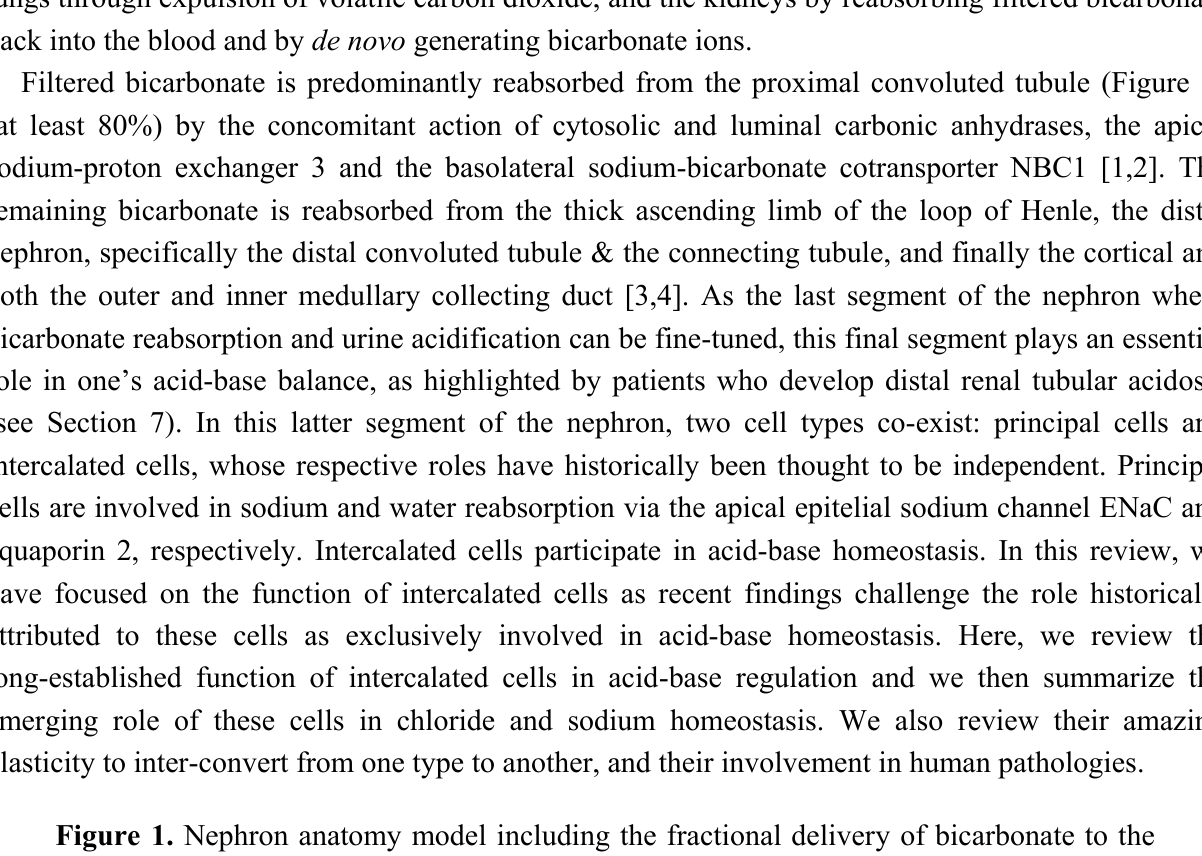
Figure 1. Nephron anatomy model including the fractional delivery of bicarbonate to the various nephron segments. The fractional delivery (FD) values of bicarbonate to the various sites are only indicative, as they vary with an individual’s diet